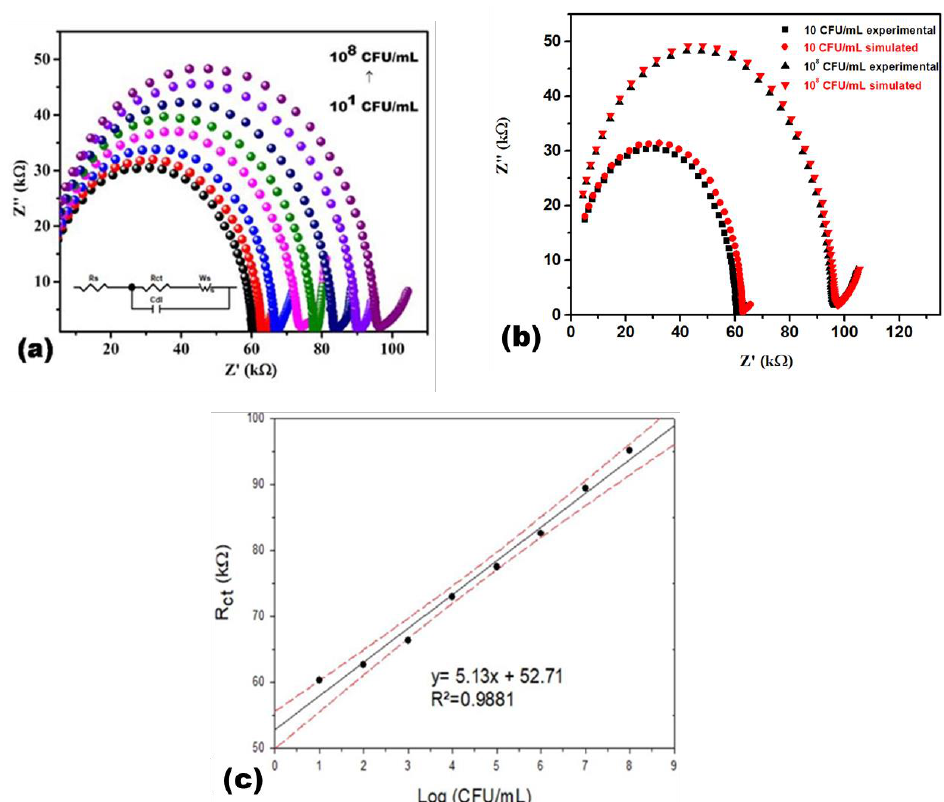
Figure 3. ( a ) Nyquist plot of bacteria/Aptamer/WS 2 NS/ePADat various bacteria concentrations (10 1 to 10 8 ). The Randel’s equivalent circuit is shown in the inset; ( b ) curve fitting of Nyquist spectra using circuit simulation of Randel’s equivalent model; ( c ) sensor calibration line with confidence intervals (95%) for calculation of LOD and LOQ with the graphical method by Meier and Zund, indicating direct dependence of the R ct on bacteria concentrations, in 0.1 M KCl containing 0.1 mM methylene blue (frequency range of 100 Hz–10 MHz).